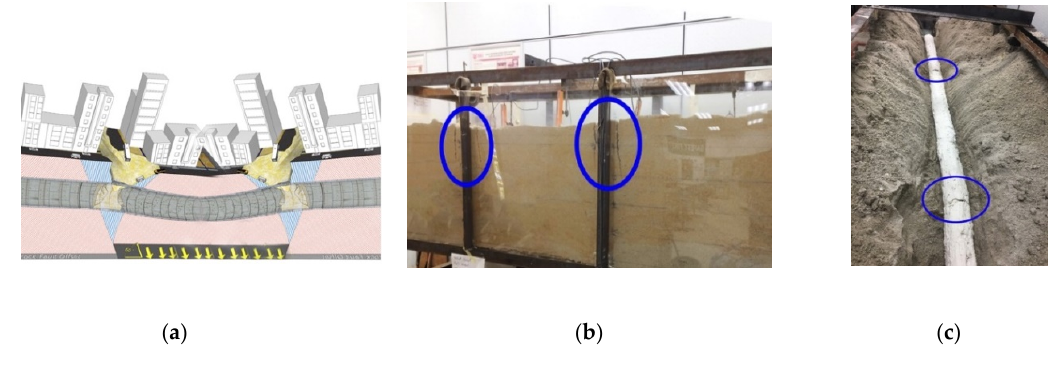
Figure 12. Failure when normal fault happens: ( a ) schematic diagram, ( b ) displacements, and ( c ) tunnel failure.